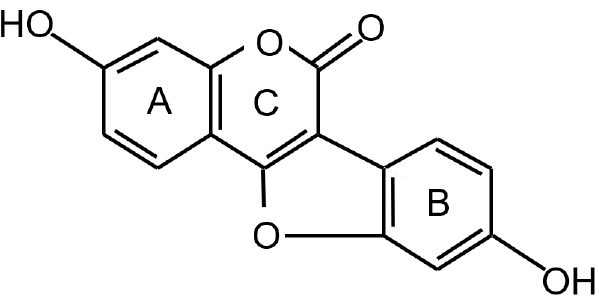
Figure 1. Chemical structure of coumestrol.